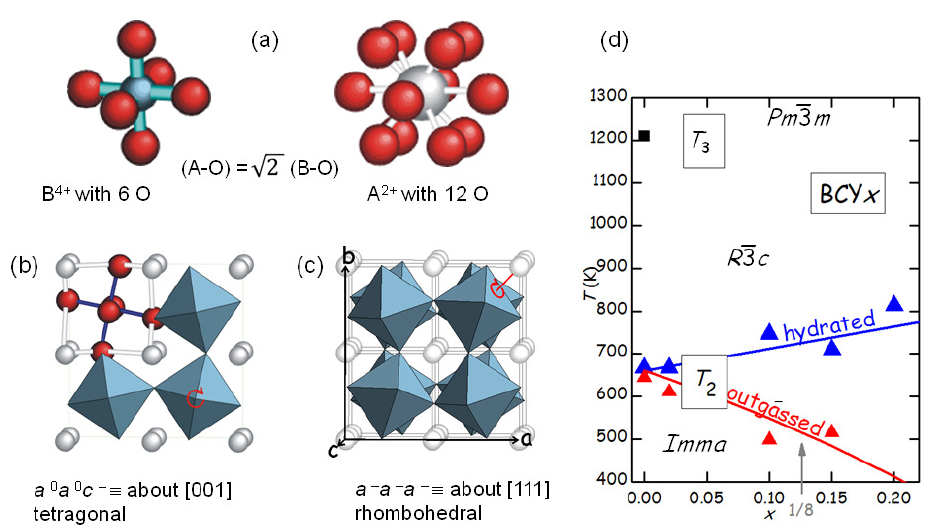
Figure 7. ( a ) BO 6 octahedra and AO 12 polyhedra in a cubic perovskite. During cooling, the more rigid and incompressible octahedra tilt in order to fit in the more anharmonic A-O framework. The tilt pattern in ( b ) is that of SrTiO 3 below 105 K, while that in ( c ) is for the rhombohedral phase of BCY or the ferroelectric phase of Zr-rich PZT. ( d ) Temperatures T 2 of the transition PT2 versus Y doping in the outgassed and hydrated states of BCY; T 3 is the temperature of